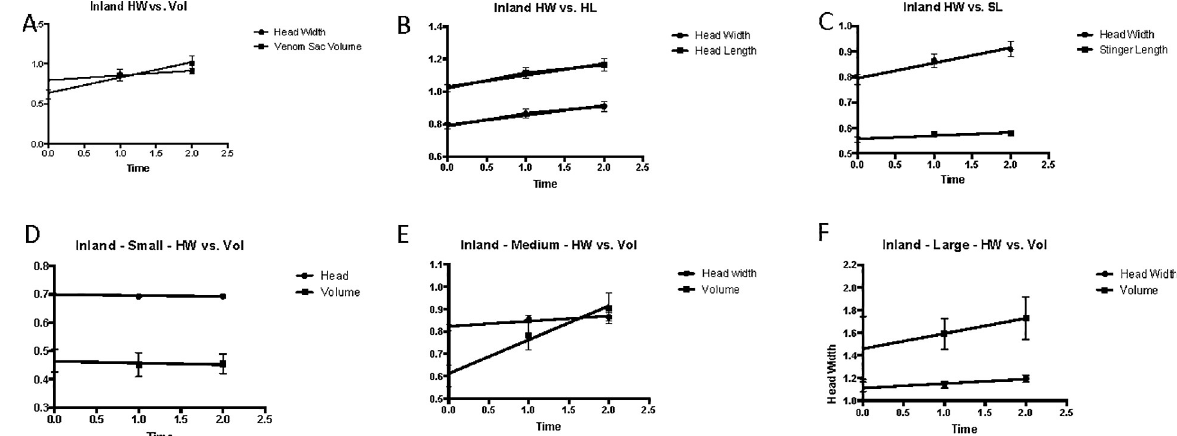
Fig 12. Linear regression analysis of inland workers during the flood. A. Total inland head width and volume vs. time. B. Complete inland head width and head length vs. time. C. Complete inland head width and stinger length vs. time. D. Small inland head width and volume vs. time. E. Medium inland head width and volume vs. time. F. Large inland head width and volume vs. time.